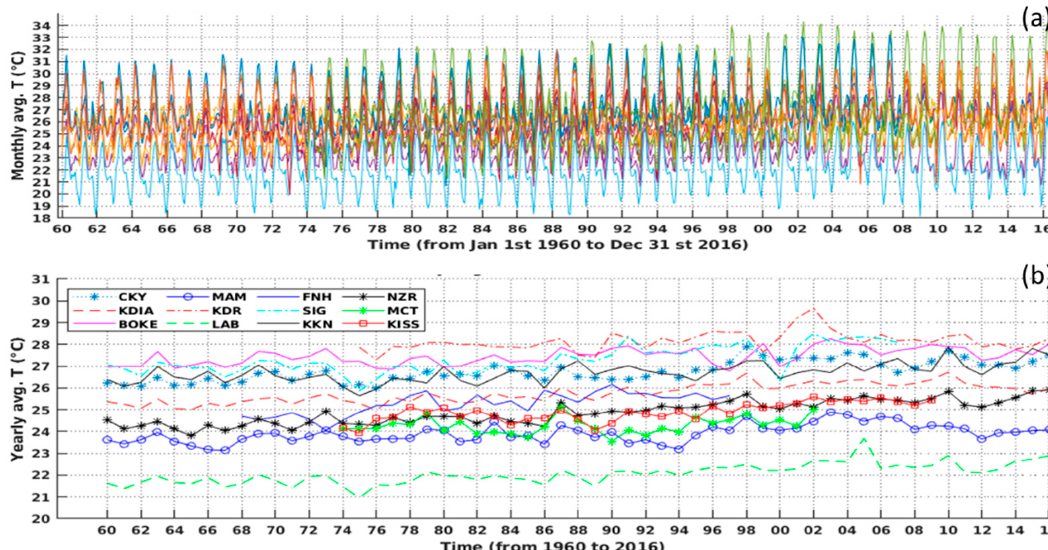
Figure 5. The inter-annual evolution of: ( a ) the monthly averaged temperature and ( b ) the yearly averaged temperature for the 12 weather stations in Guinea (CKY~Conakry, KDIA~Kindia, BOKE~Boke, MAM~Mamou, KDR~Koundara, LAB~Labe, FNH~Faranah, SIG~Siguiri, KKN~Kankan, NZR~N’zerekore, MCT~Macenta, and KISS~Kissidougou), from 1960 to 2016.